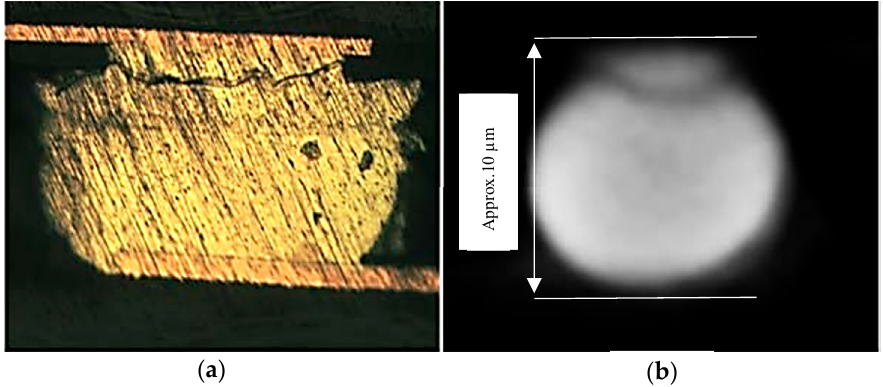
Figure 6. Crack detection in a micro solder bump: ( a ) metallographic microscopic image; ( b ) slice-by-slice inspection of µ CT images [36].